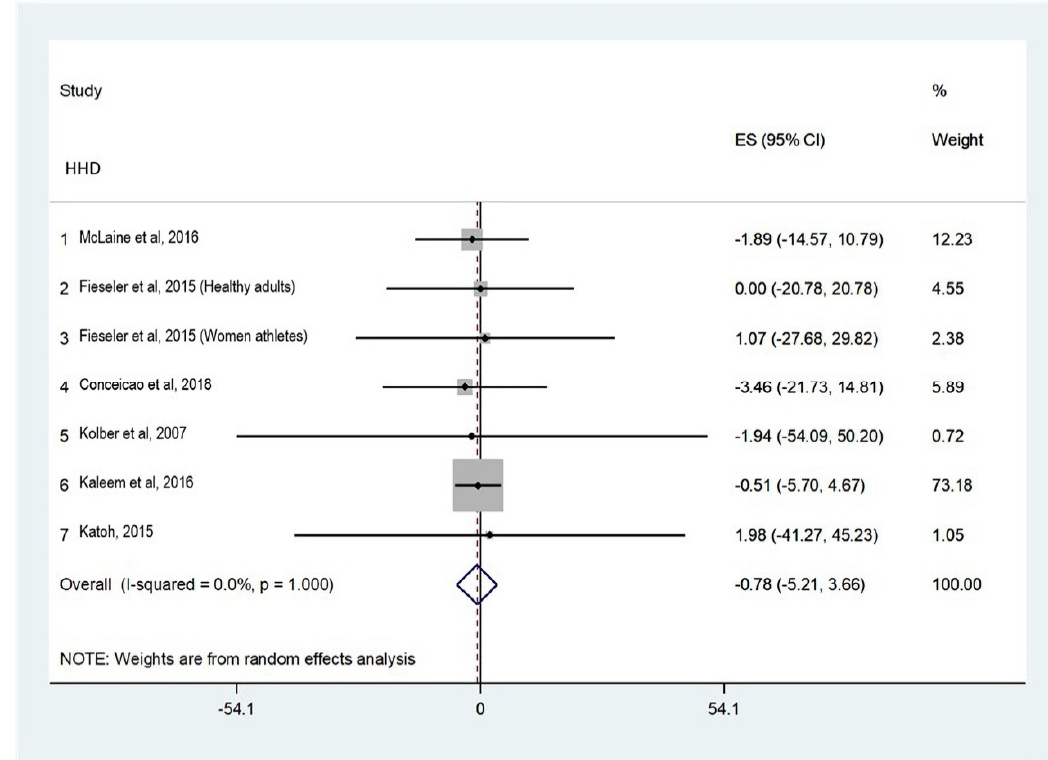
Figure 3. Absolute reliability for shoulder external rotator strength assessment .